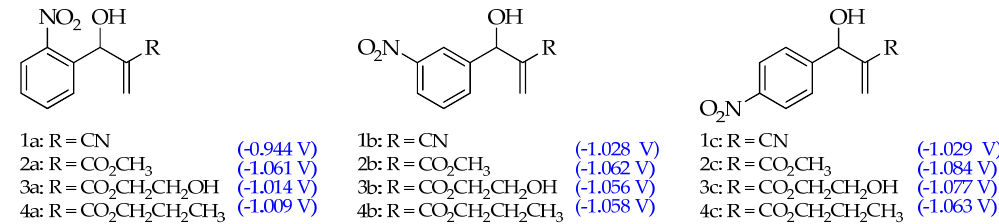
Figure 1. Chemical structures of the studied nitroaromatic Morita–Baylis–Hillman adducts (MBHA) and corresponding E cp1 values.